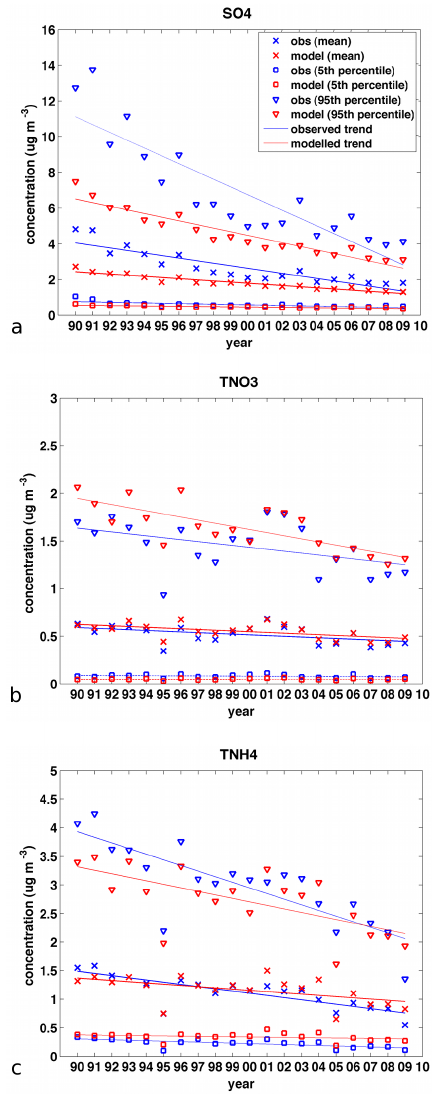
Figure 5. Observed (blue) and modelled (red) annual mean (crosses), 5th percentile (squares) and 95th percentile (triangles) and corresponding trend line of (a) SO 2 − , (b) TNO 3 and (c) TNH 4 . 4 Solid lines indicate a significant and dashed lines a non-significant trend (only found for the TNO 3 5th